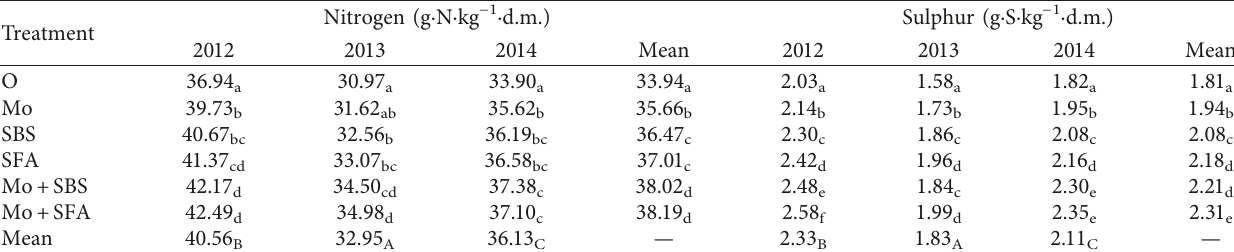
Table 4: The influence of Mo and S application on the nitrogen and sulphur content.